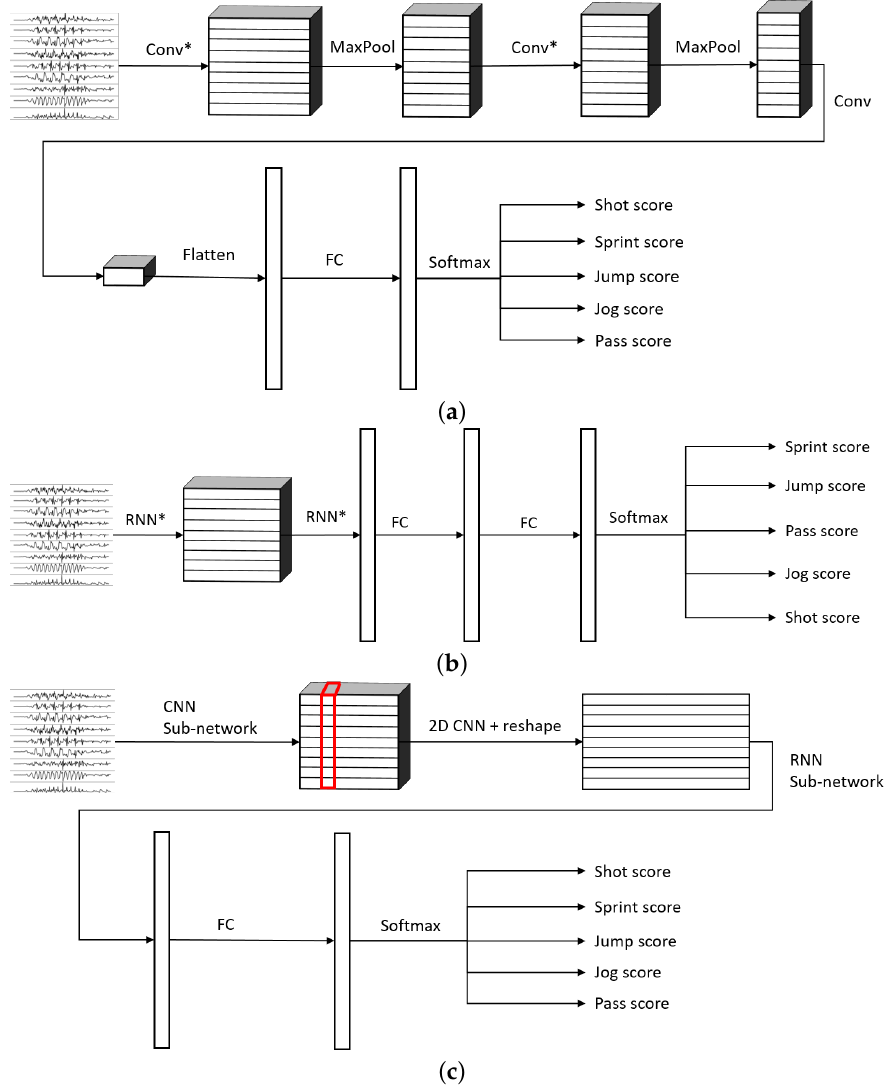
Figure 4. General architectures of the different types of models built. Three types of models were evaluated: using only CNN, only RNN, or a combination of both. The asterisks on the Conv layers mean the usage of a variation of a convolutional layer. The asterisks on the RNN layers represent either LSTMs or bidirectional LSTMs. (FC = Fully Connected Feed Forward Neural Network). ( a ) General architecture for models based on CNNs, ( b ) general architecture for models based on RNNs, ( c ) general architecture for models based on combination of CNNs followed by